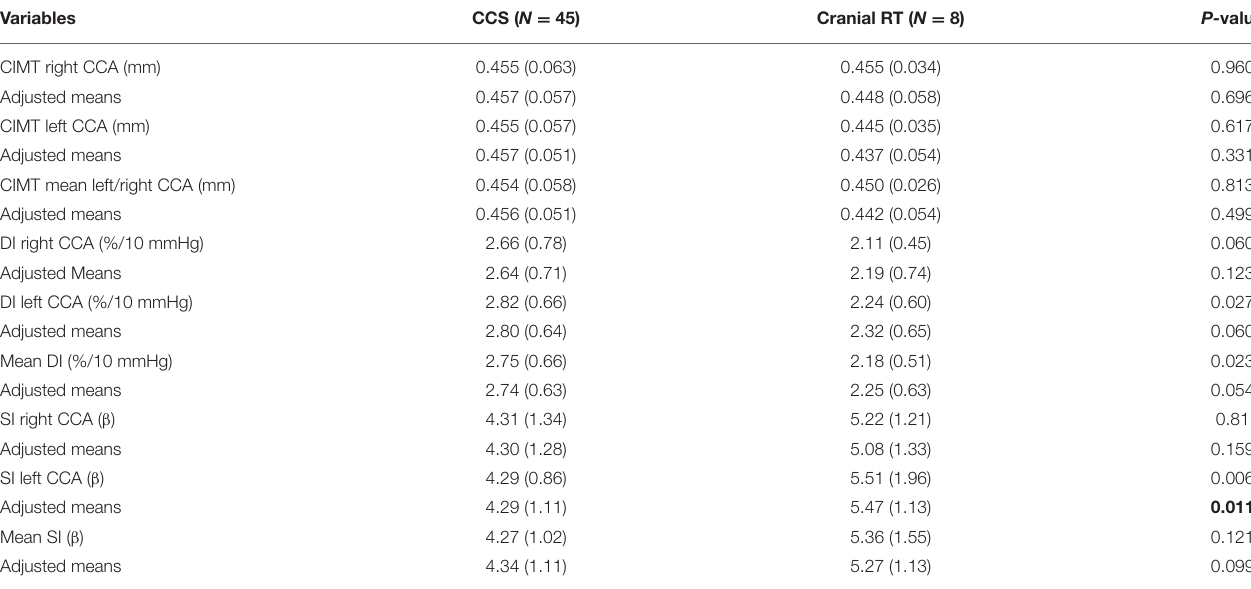
TABLE 4 | Carotid measures in CCS treated with cranial